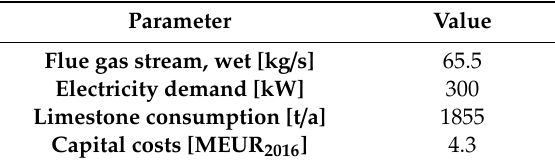
Table A7. Parameters description SCR [18].